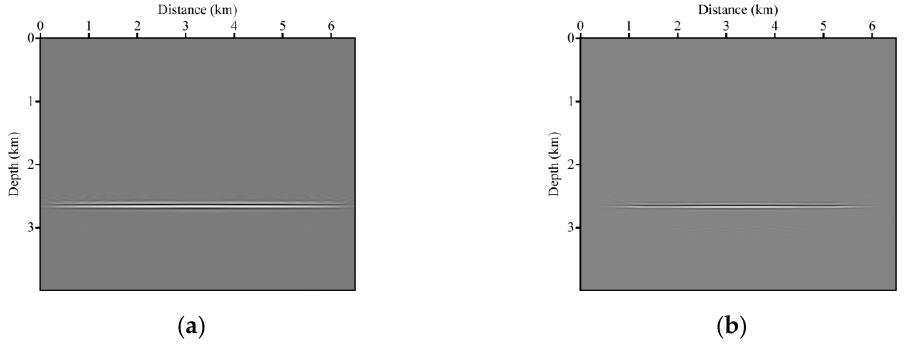
Figure 8. ERTM profile with fewer artifacts compared with Figure 5: ( a ) PP imaging; ( b ) PS imaging.